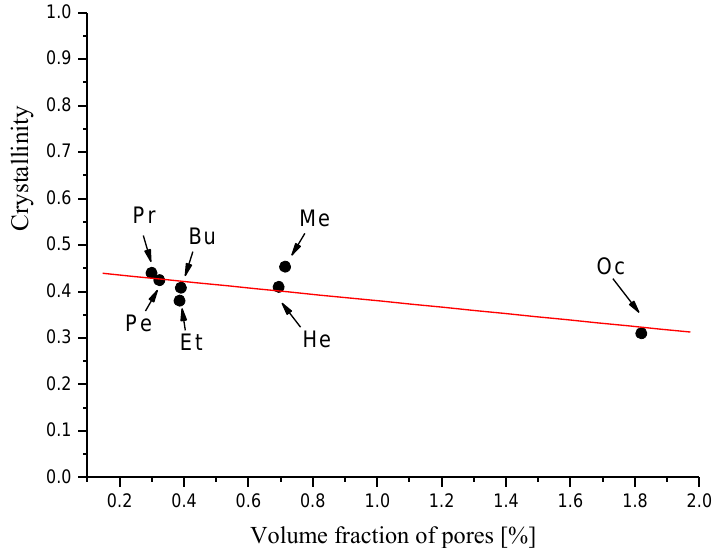
ff ect of the pore volume fraction on the membrane Figure 9. Effect of the pore volume fraction on the membrane crystallinity. Figure 9. E